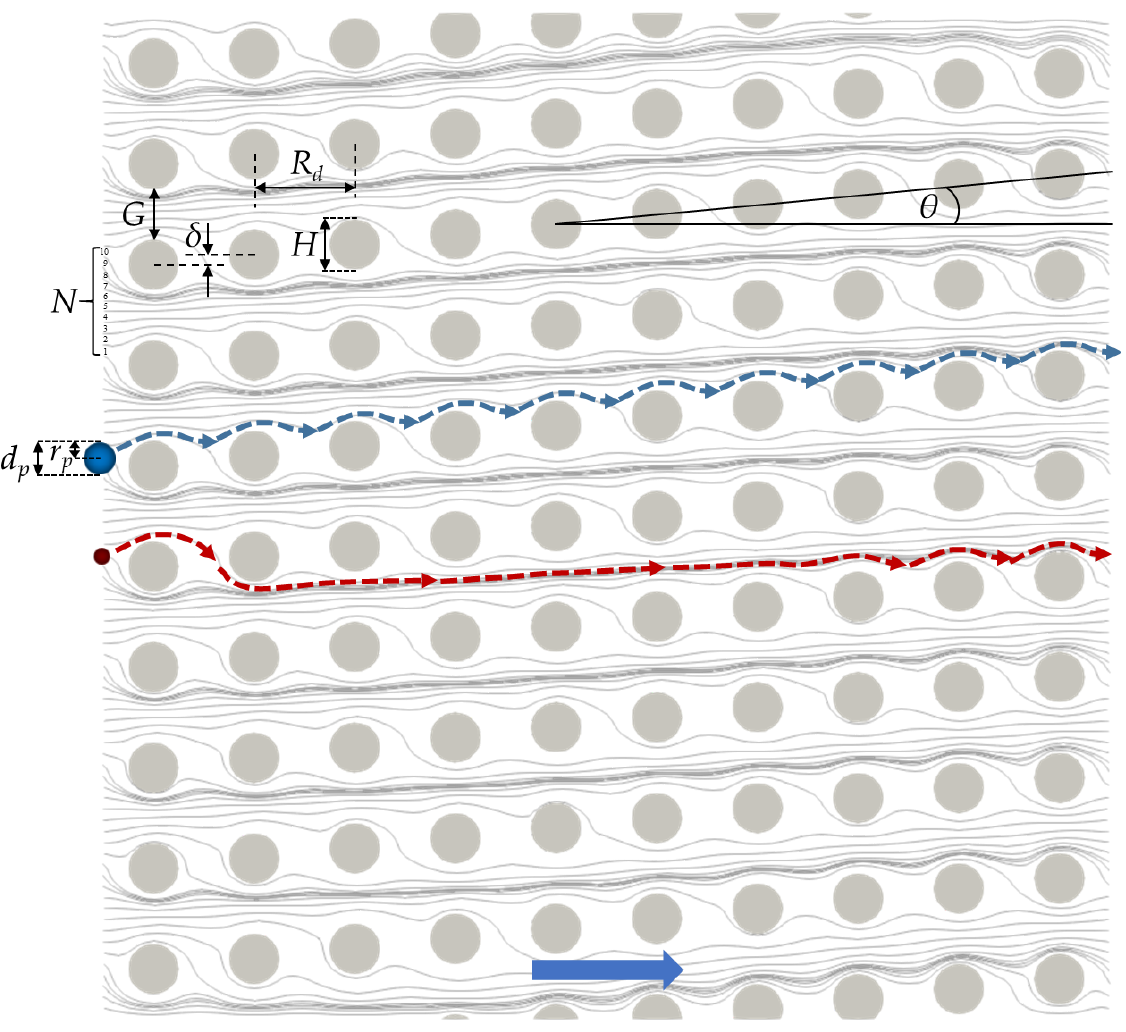
Figure 1. Schematic illustration of the principles of DLD, here with a periodicity ( N ) of 10.